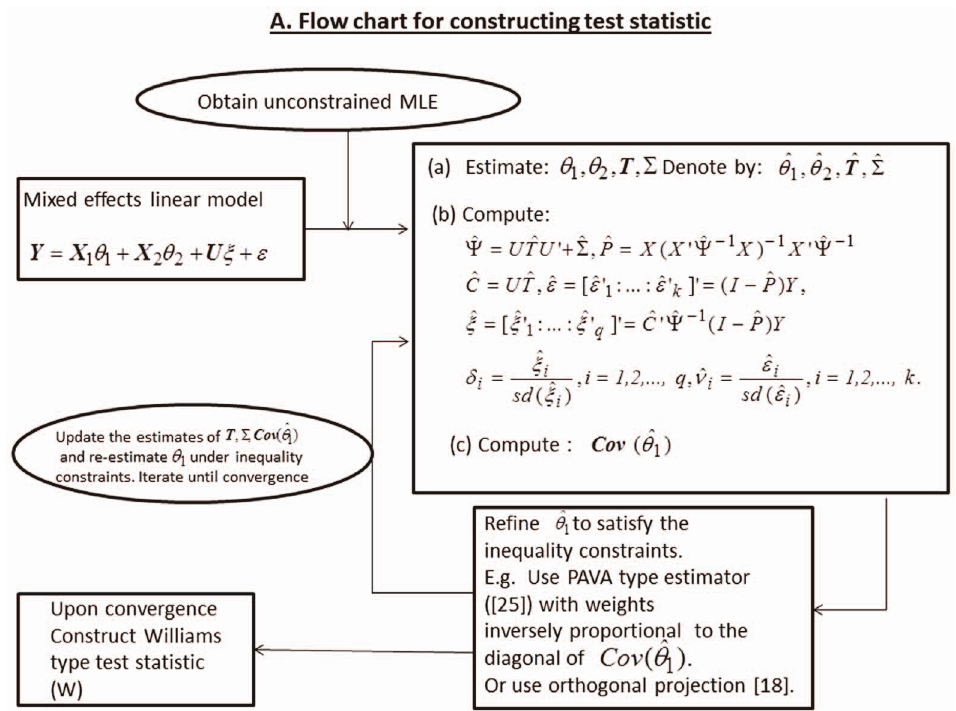
Figure 2. Flow chart for constructing test statistic.